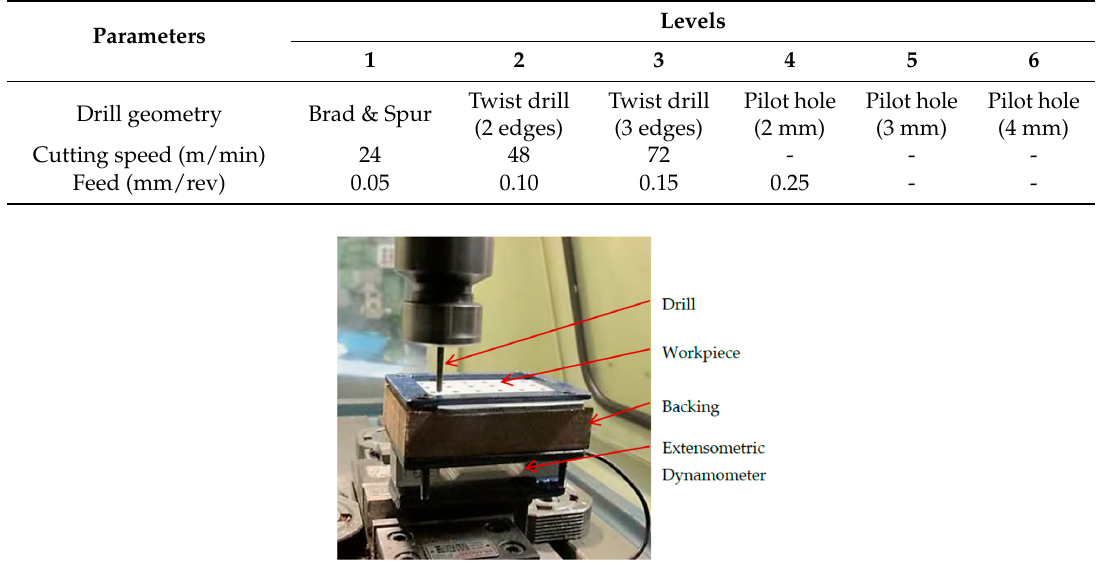
Figure 4. Experimental set-up for the drilling tests.